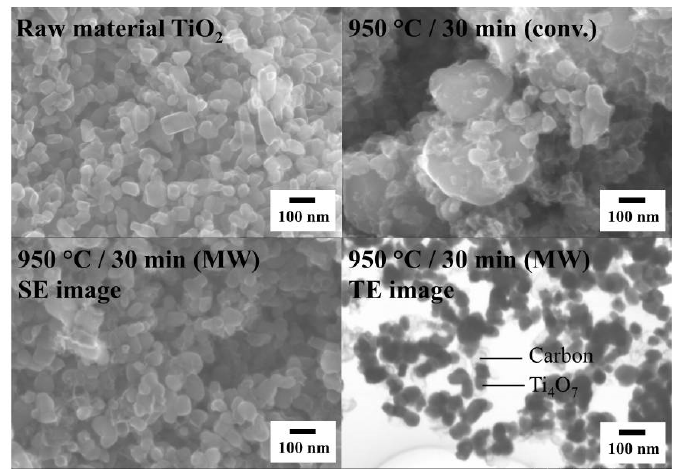
Figure 4. Field Emission Scanning Electron Microscope images of the raw material TiO 2 and samples heated by microwave and conventional heating at 950 °C for 30 min.